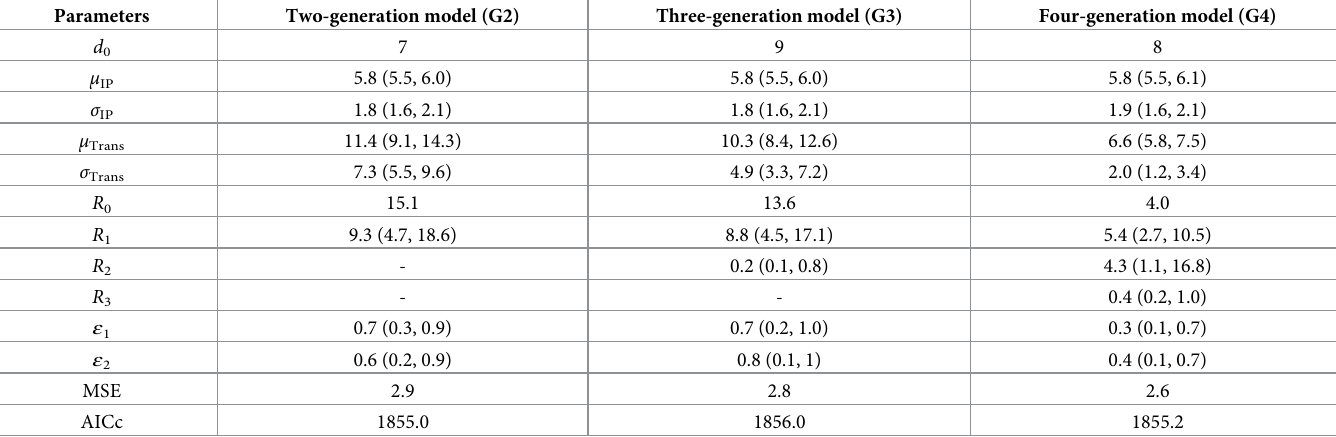
Table 2. Estimates of the best models by number of